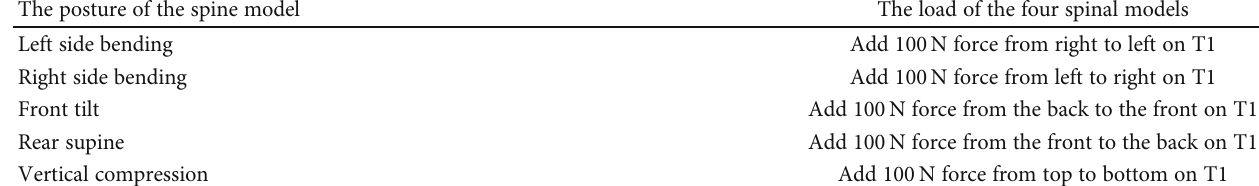
Table 3: The external load addition in four spinal models